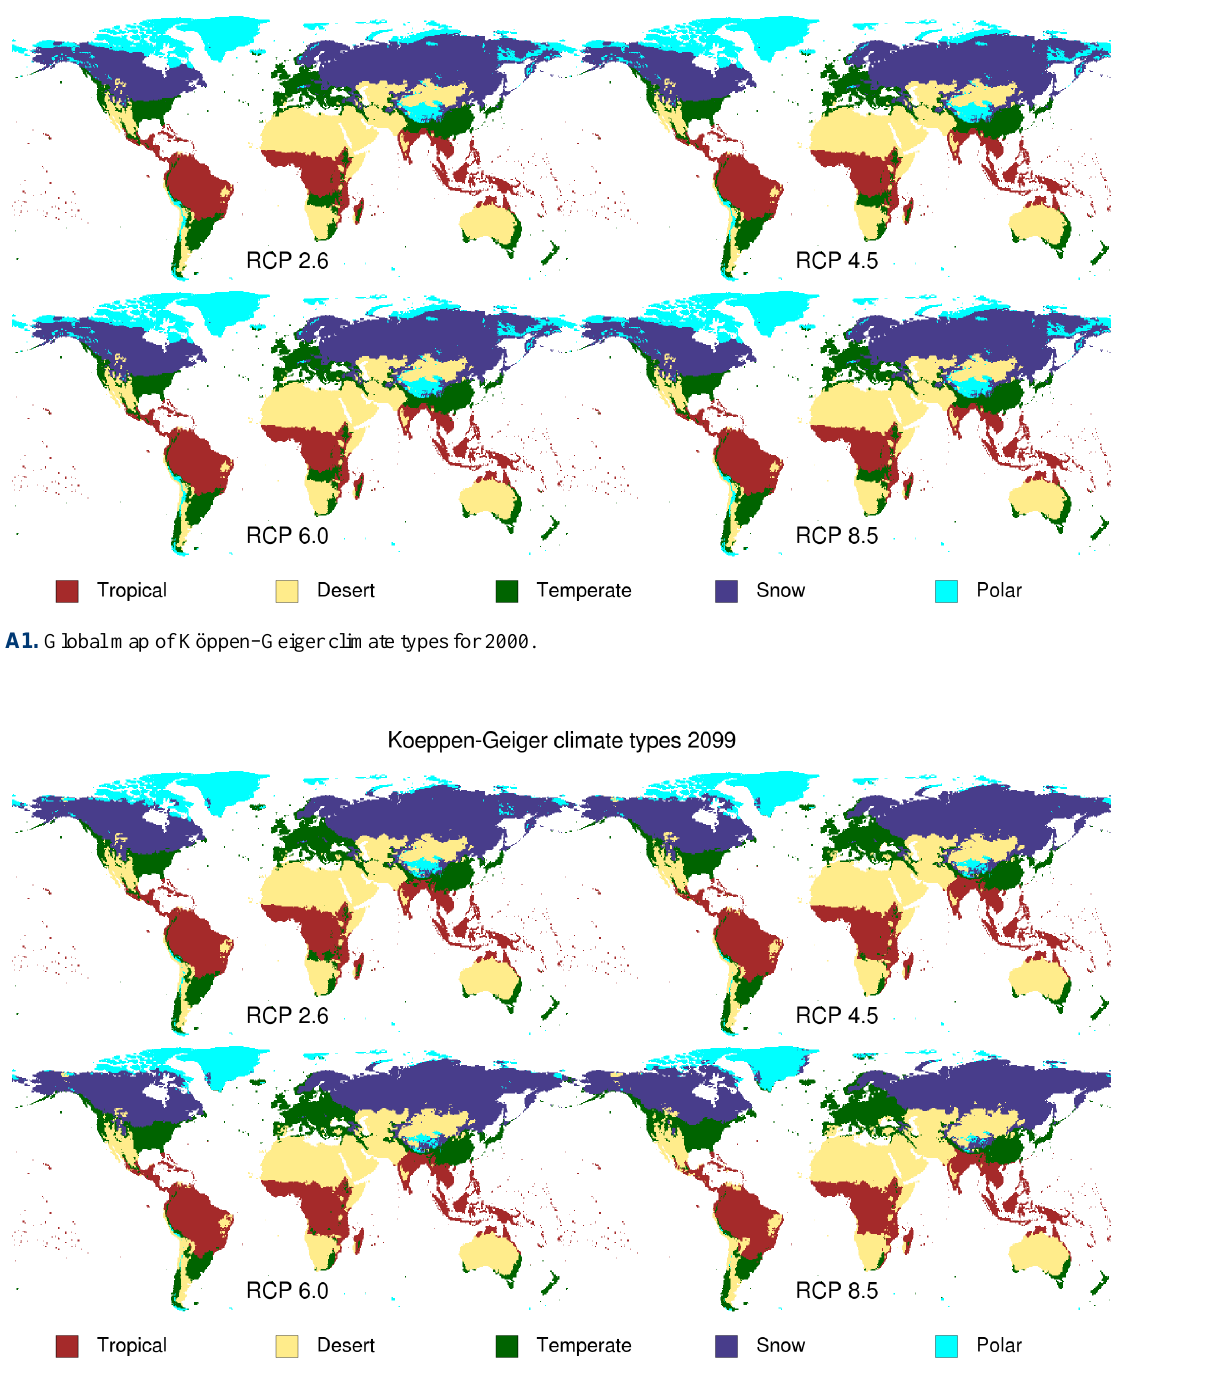
Figure A2. Global map of Köppen–Geiger climate types for